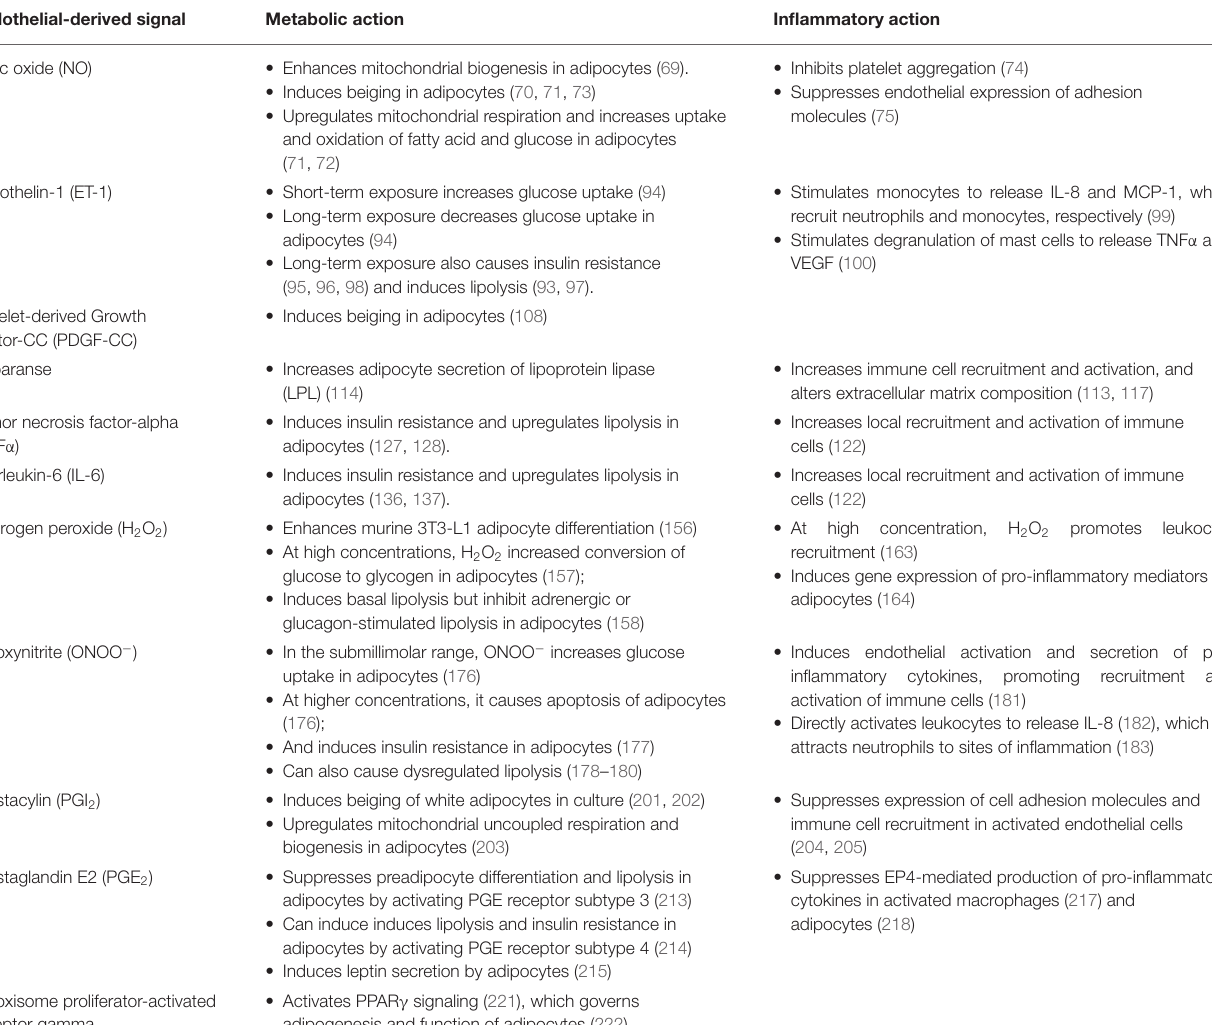
TABLE 1 | Metabolic and inflammatory actions of endothelial-derived signals in AT under normal and pathophysiological conditions in CMS. Endothelial-derived